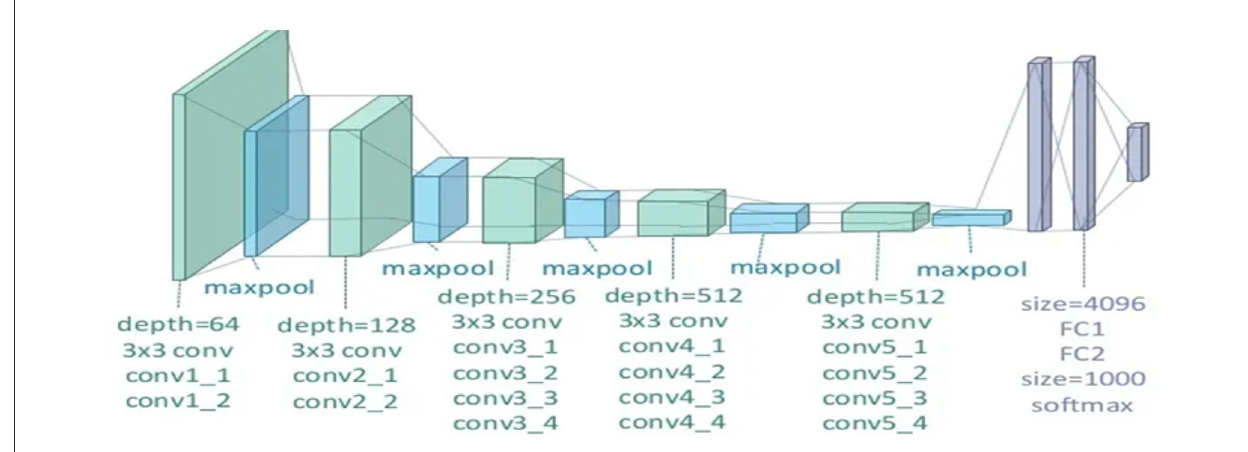
FIGURE6 Illustration of the network architecture of VGG-19 model (Abuared et al., 2020).